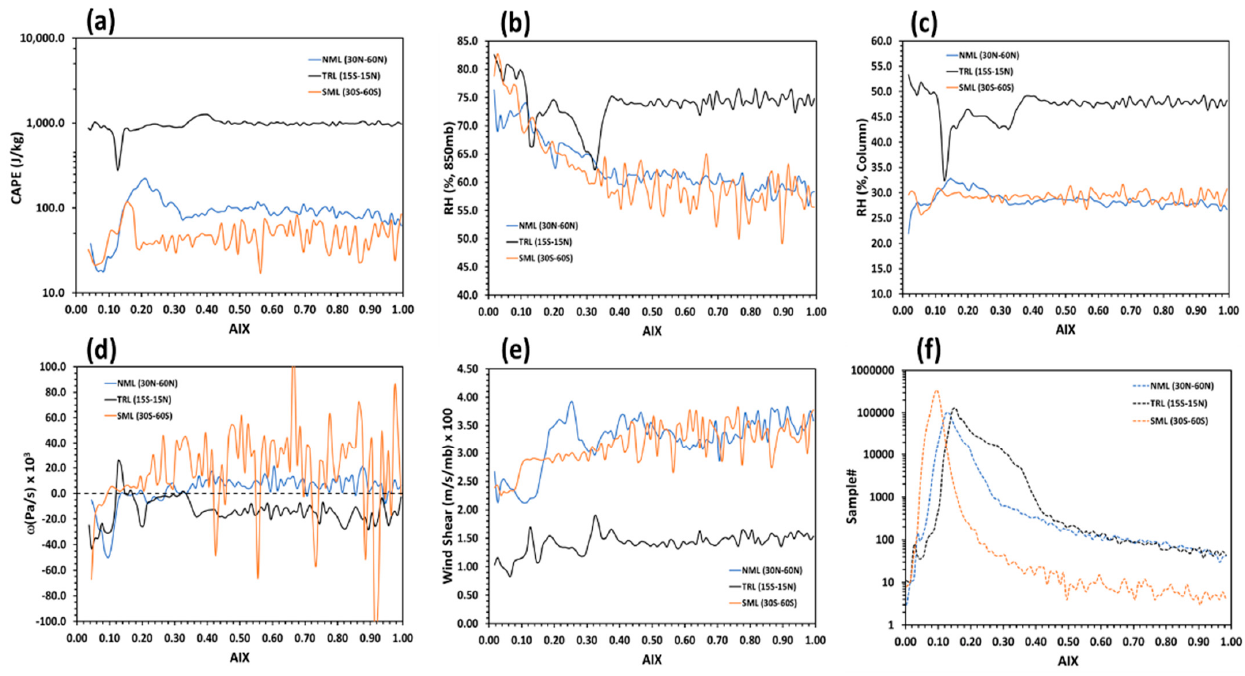
Figure 6. Same as Figure 5 but for ( a ) CAPE, ( b ) RH 850 , ( c ) RH clm , ( d ) ω 850 , and ( e ) VSHW along with ( f ) the sample size for their long-term averaged values in the three latitudinal regions (NML, TRL, and